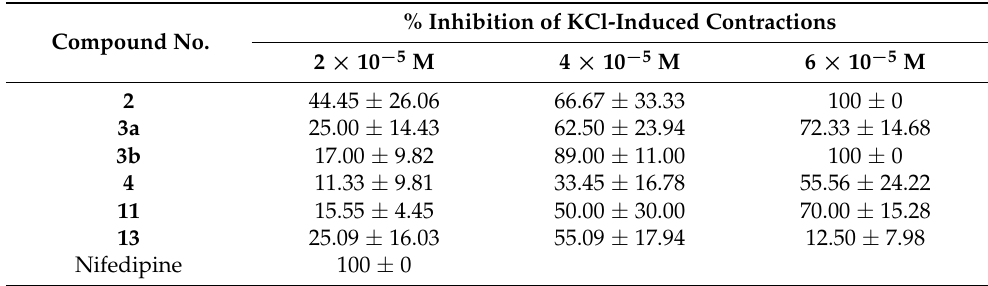
Table 2. Quantitative assessment of active compounds expressed as % inhibition of KCl-induced contractions on isolated rabbit jejunum at different concentrations ( n = 4) a . Compound No.